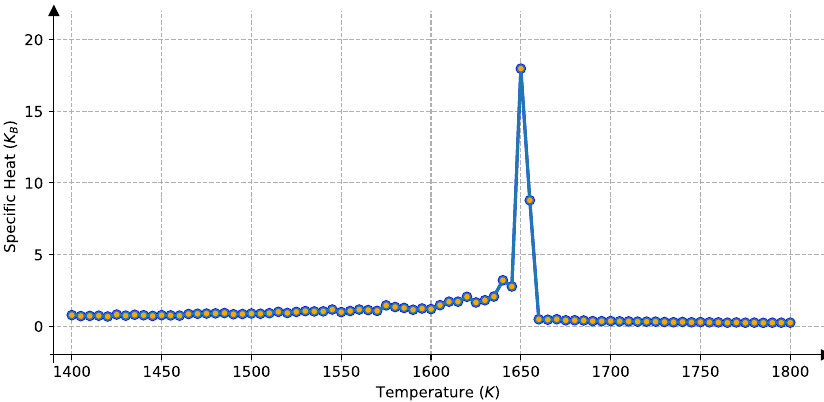
Figure 2. Specific heat capacity of AlCoFeNi HEAs.